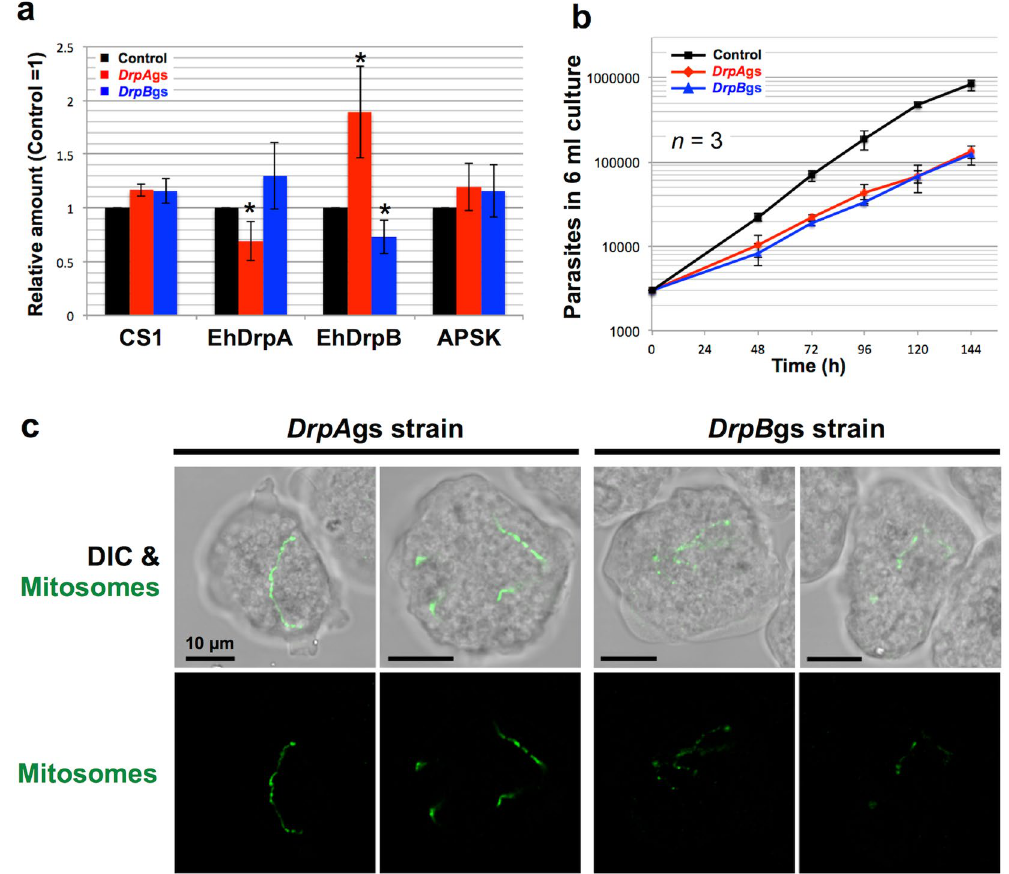
Figure 4. Effects of repression of gene expression of EhDrpA and EhDrpB genes. ( a ) Relative amounts of EhDrpA, EhDrpB, APSK (mitosomal matrix protein), and cysteine synthase 1 (CS1, BAA21916, as an irrelevant control gene) in the strains where EhDrpA or EhDrpB gene was silenced [ DrpA gs (red bars) and DrpB gs (blue bars)]. Control (black bars) indicates the strain transfected by the empty vector. The intensities of the bands in the immunoblots (Supplementary Fig. S8) were measured and shown relative to the control. Approximately 20 µ g protein per lane was subjected to SDS-PAGE. Error bars indicate standard deviations of three replicates. * P < 0.05 (Student t-test). ( b ) Growth kinetics of DrpA gs, DrpB gs, and control strains. Error bars indicate standard deviations of triplicates. ( c ) Immunofluorescence images of mitosomes in DrpA gs and DrpB gs strains by confocal microscopy. Mitosomes (green) were stained by anti-APSK antibody and Alexa Fluor ® 488 goat anti-rabbit IgG. DIC indicates the differential interference contrast image. These images are approximately 1.0 µ m in thickness per section. Scale bar = 10 µ m. Experiments were performed three times and more than 40 cells were observed for each